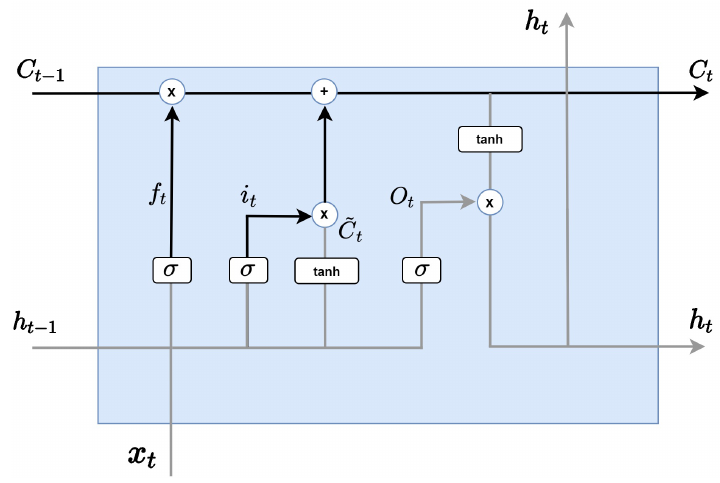
Figure 5. LSTM cell state update.